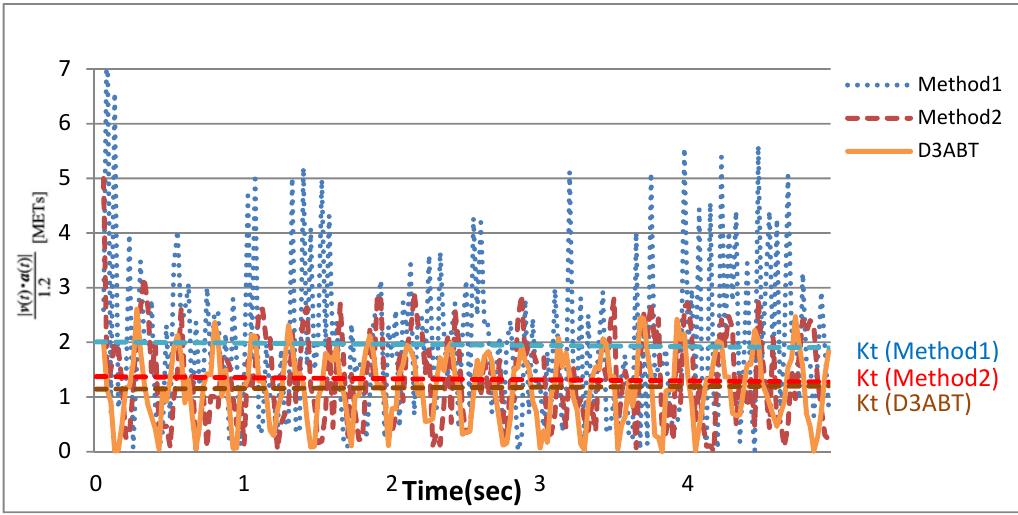
of D3ABT, Method1, and t